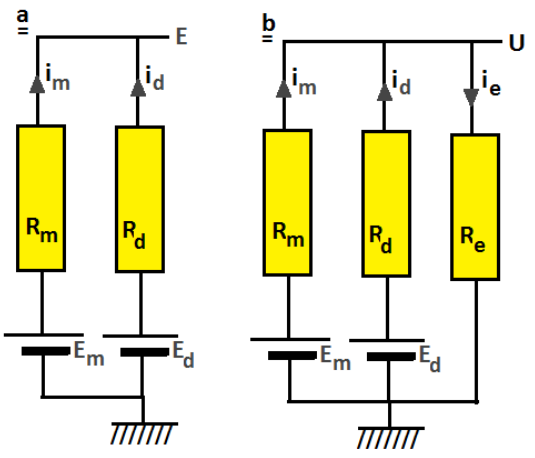
Figure 3. Model of a RED-stack operating on a mixture of mono- and divalent ions without an external resistance ( a ) and with an external resistance ( b ).